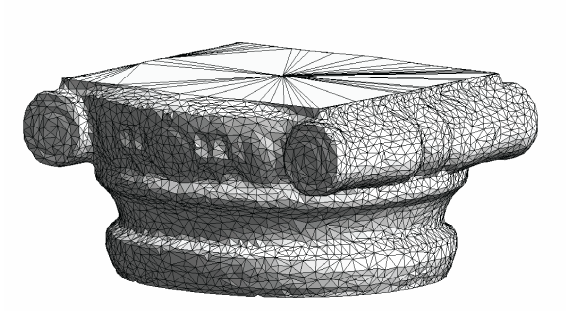
Figure 8. Mesh model of one of the Ionic capitals of the temple of Antas derived from the dense point cloud